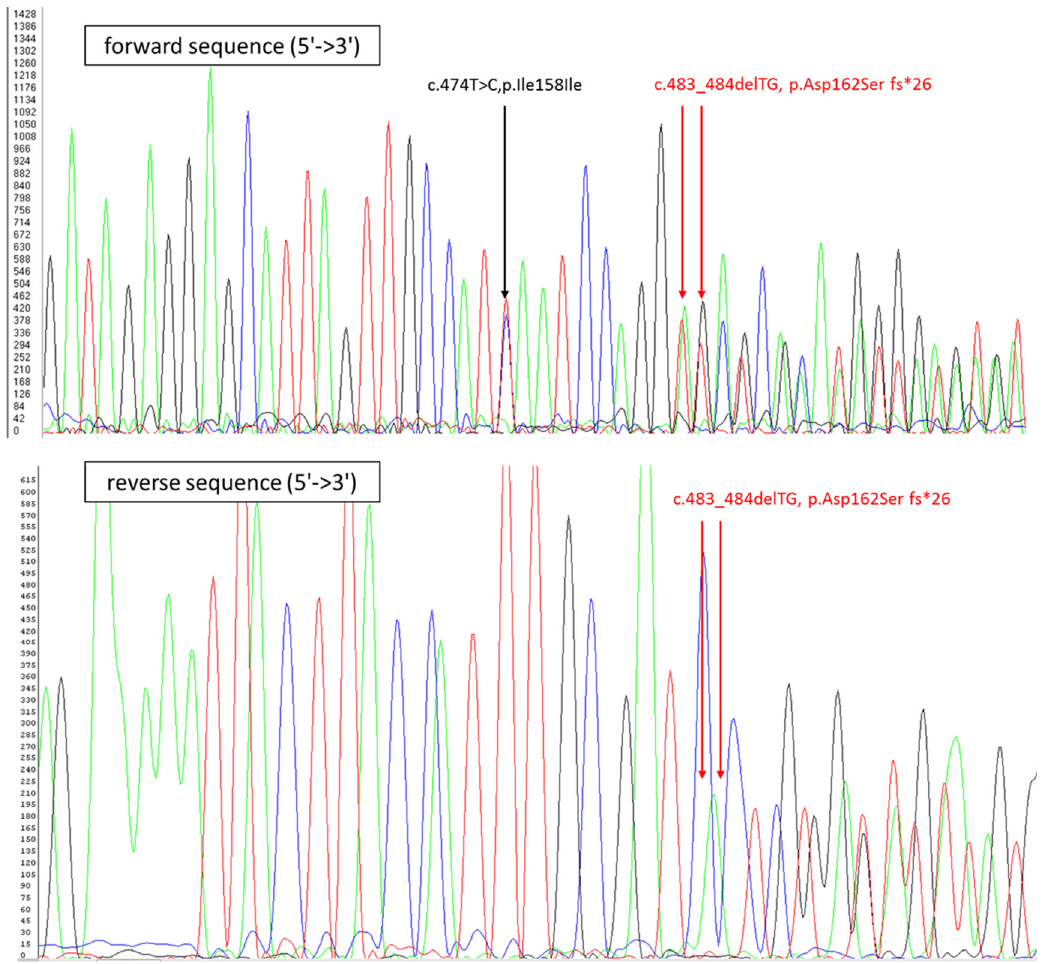
Figure 3. Electropherogram obtained with the SeqScape v2.5v software ( APPLIED Biosystem, Foster City, CA, USA) representing part of the sequence of TPMT exon 7. The black arrow shows a silencing mutation. The red arrow shows a novel c.483_484del, p.Asp162Serfs * 26 mutation that generates a premature stop codon in exon 8.